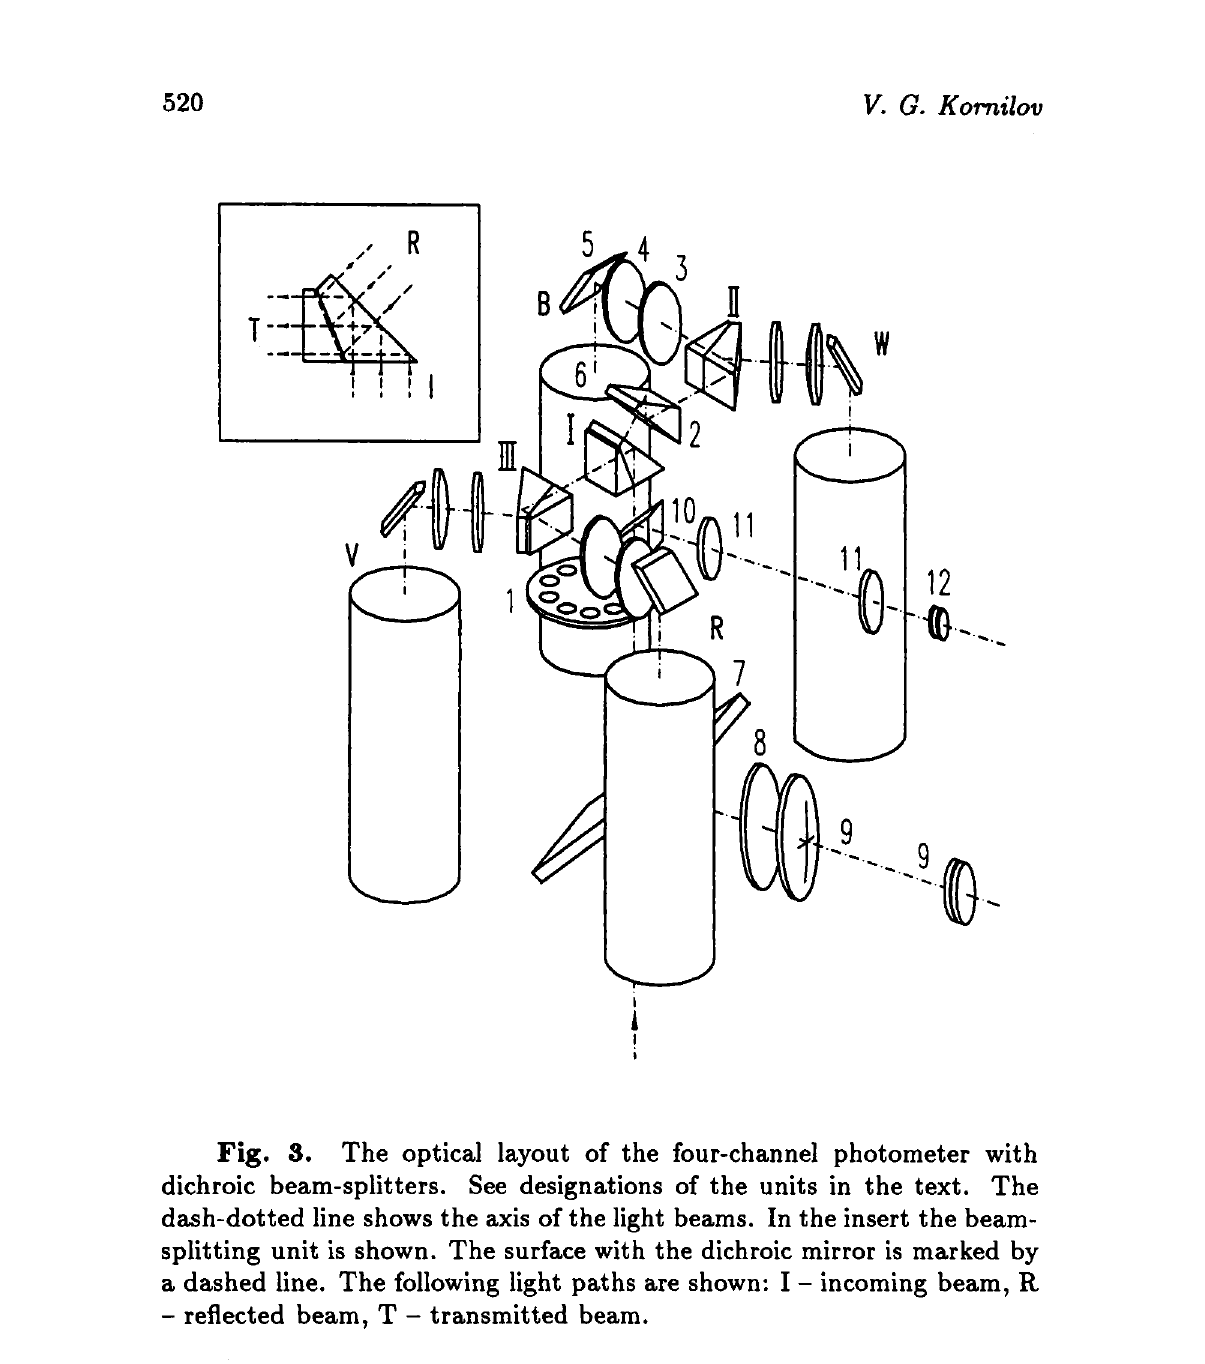
Fig. 3. The optical layout of the four-channel photometer with dichroic beam-splitters. See designations of the units in the text. The dash-dotted line shows the axis of the light beams. In the insert the beam- splitting unit is shown. The surface with the dichroic mirror is marked by a dashed line. The following light paths are shown: I - incoming beam, R - reflected beam, T - transmitted